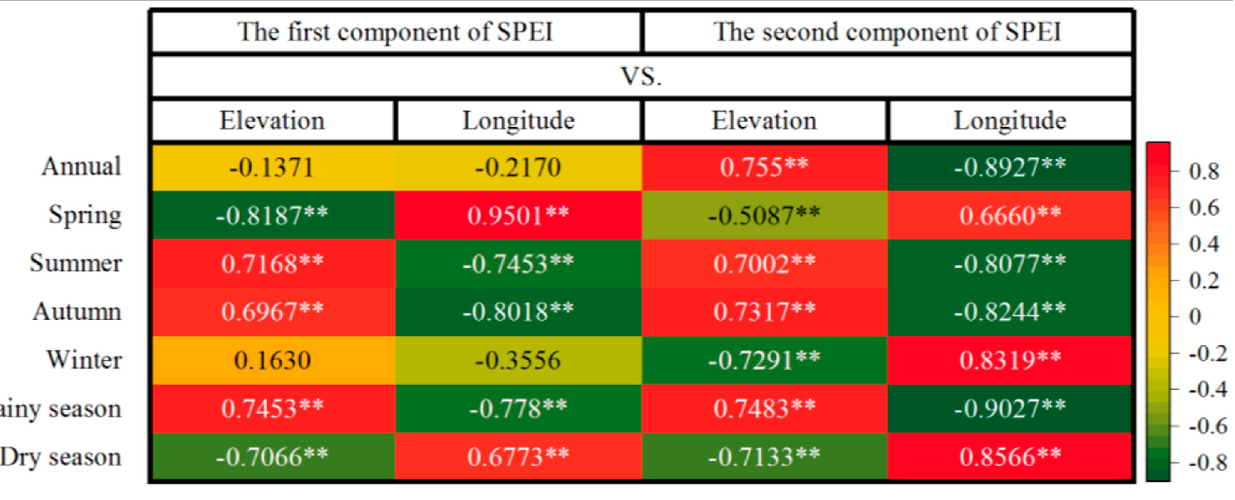
TABLE 3 | Linear correlation coef fi cient R between the fi rst two components of the SPEI and longitude and elevation.